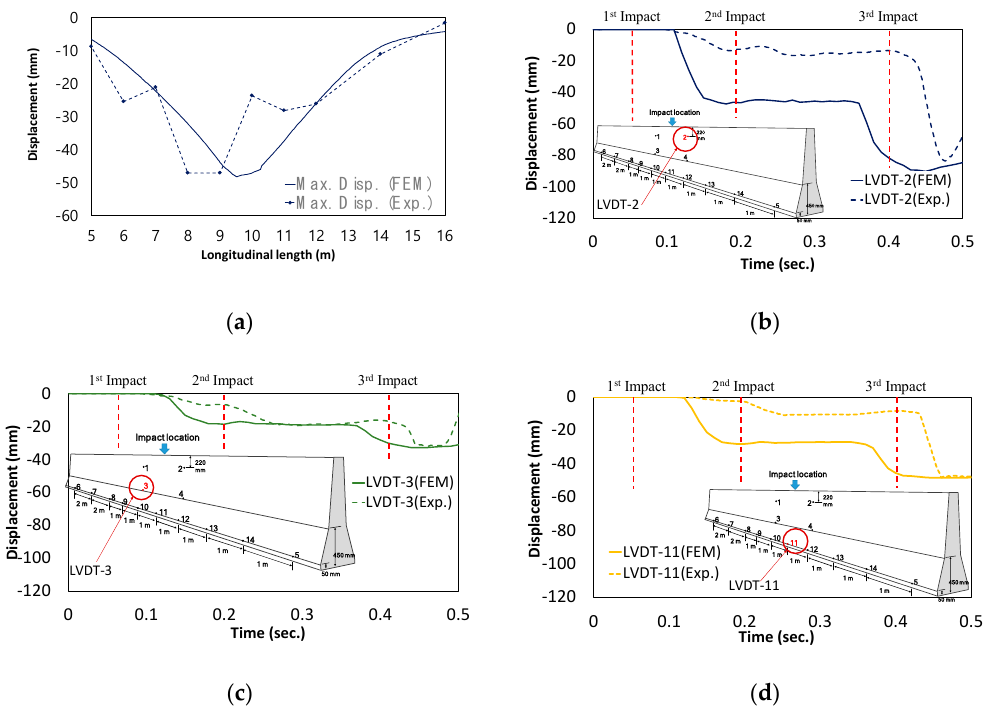
Figure 17. Comparison between numerical and experimental results. ( a ) Deformed shape; ( b ) LVDT (#2); ( c ) LVDT (#3) data from bottom right part; ( d ) LVDT (#11) data from bottom left part.